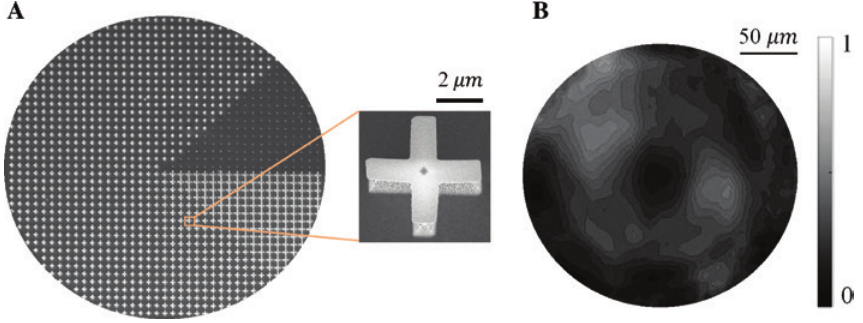
Figure 3: SEM image of the fabricated SPP and vortex beam captured using FPA detector. (A) SEM image of meta SPP for l = + 1 topological charge. The inset shows the single building block. (B) Vortex beam image captured on the 64 × 64 pixel FPA